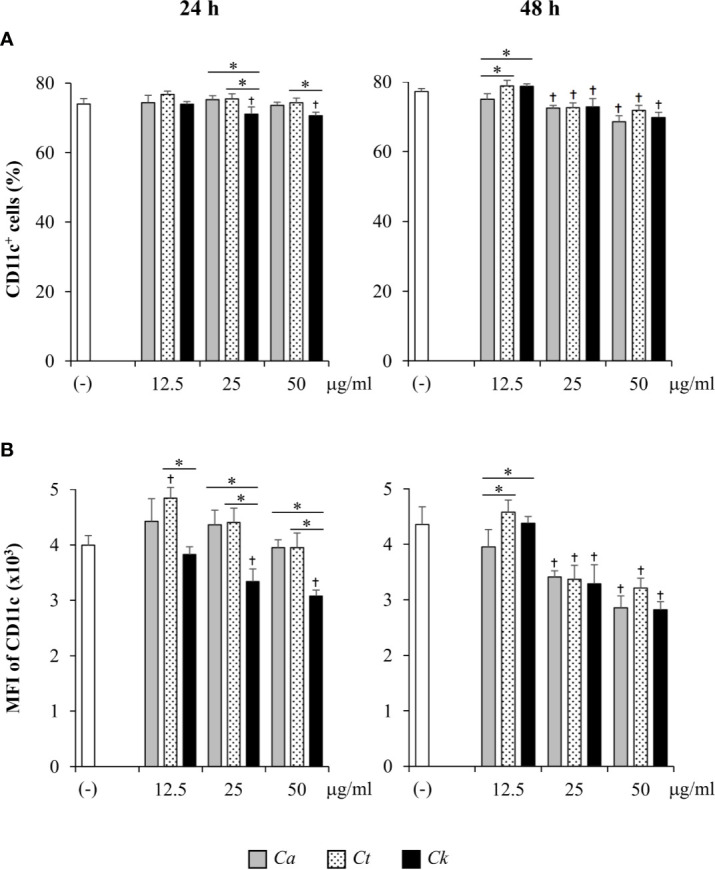
Determination of CD11c+ cell proportion and CD11c expression in bone-marrow derived dendritic cells (BMDCs) stimulated with Candida β-glucans. BMDCs were stimulated with 12.5, 25, and 50 µg/ml of β-glucans isolated from C. albicans, C. tropicalis, and C. krusei for 24 h and 48 h. Cells were analyzed by flow cytometry. (A) The percentages of CD11c+ cells were assessed using a dot pot analysis. (B) The geometric mean fluorescence intensity (MFI) of CD11c was determined using a histogram analysis. n = 5; data are representative of two independent experiments. †
p < 0.05 compared with unstimulated BMDCs, *p < 0.05. (-), unstimulated BMDCs; Ca, C. albicans; Ct, C. tropicalis; Ck, C. krusei.